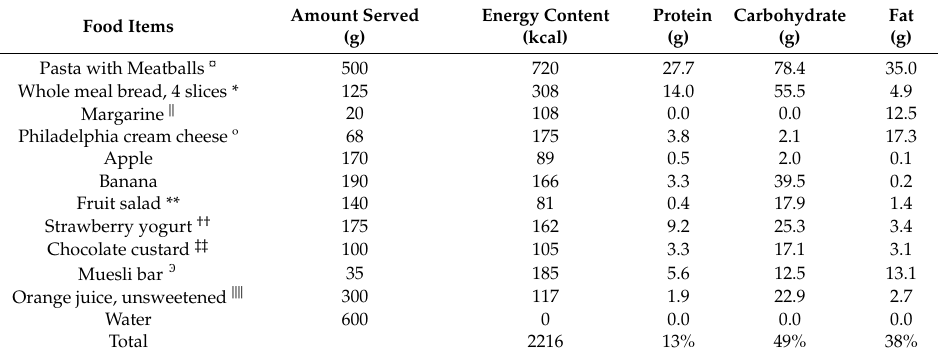
Table 2. Composition of the dinner